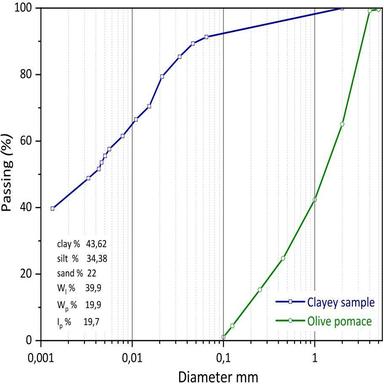
Particle size distribution of clayey sample and olive pomace.